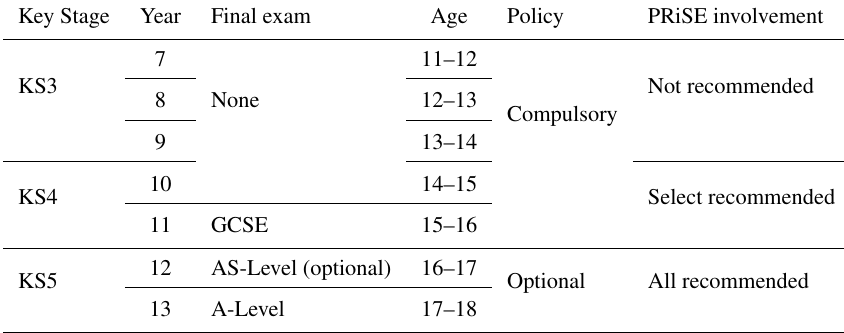
Table A1. Summary of the stages of secondary education in the English system. Key